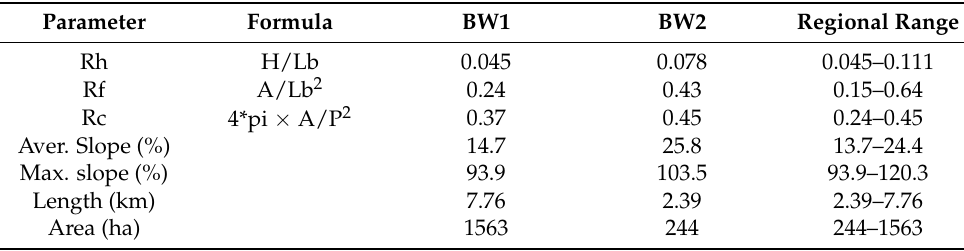
Table 1. General geomorphological features of the studied catchments.